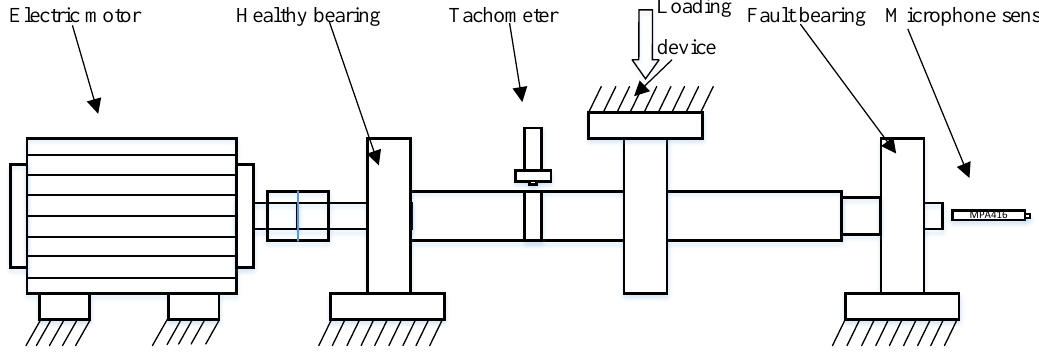
Figure 5. The test rig and installation locations of the microphone sensor.